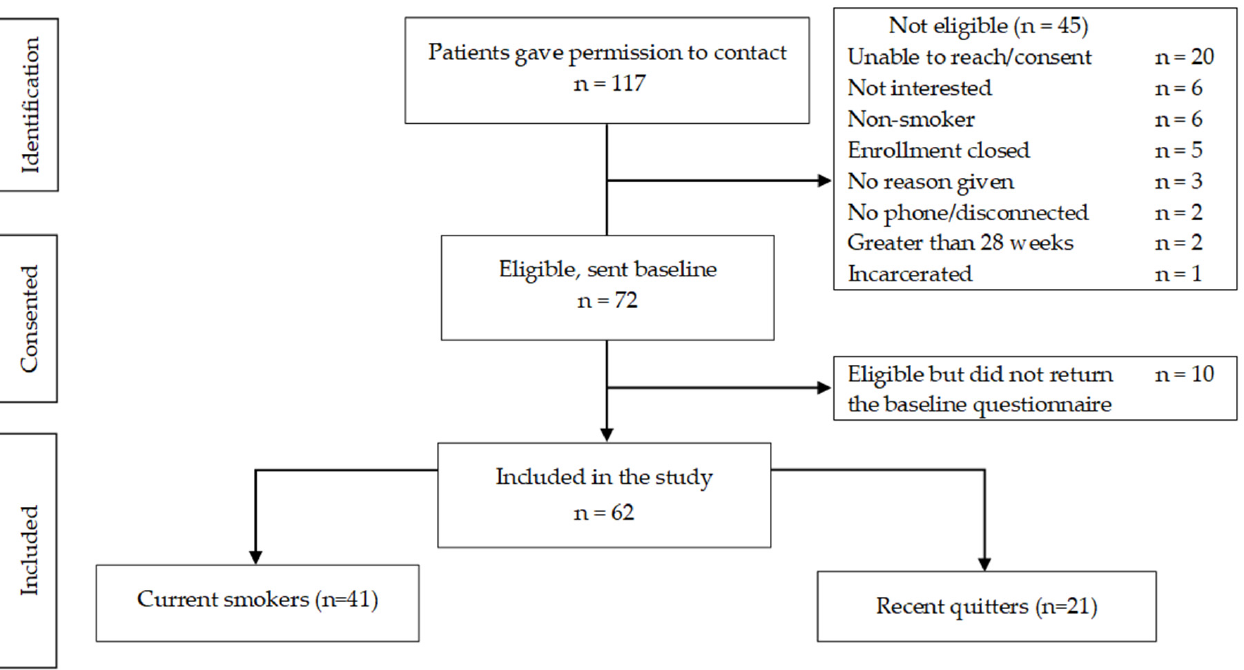
Figure 2. Recruitment flow diagram.